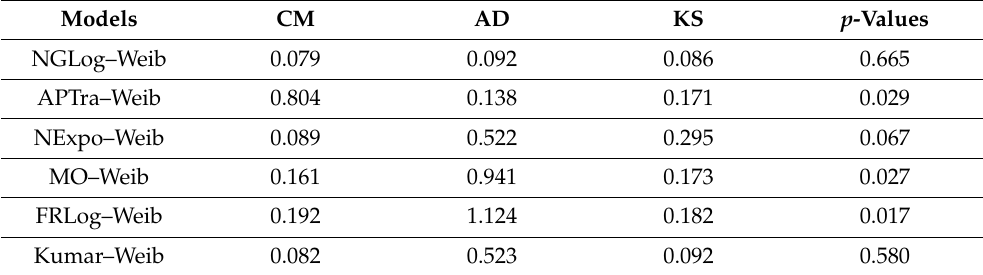
Table 7. The GFMs and p -values of the competing models for infected guinea pigs data (dataset